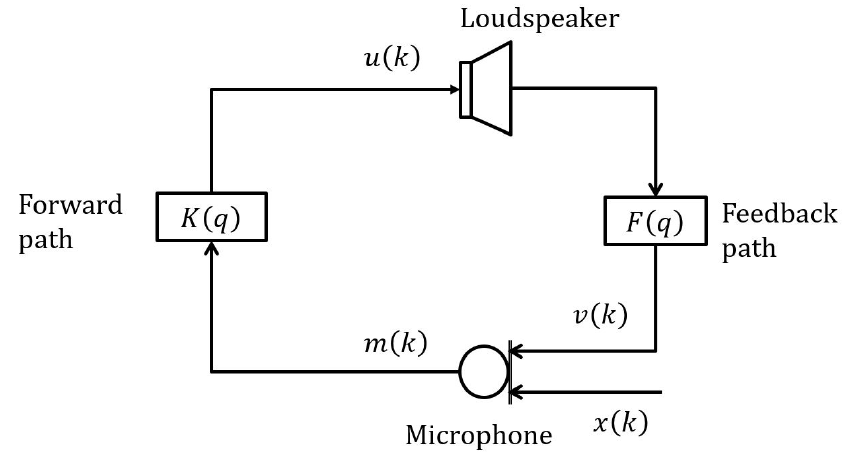
Figure 2. Typical structure of a hearing